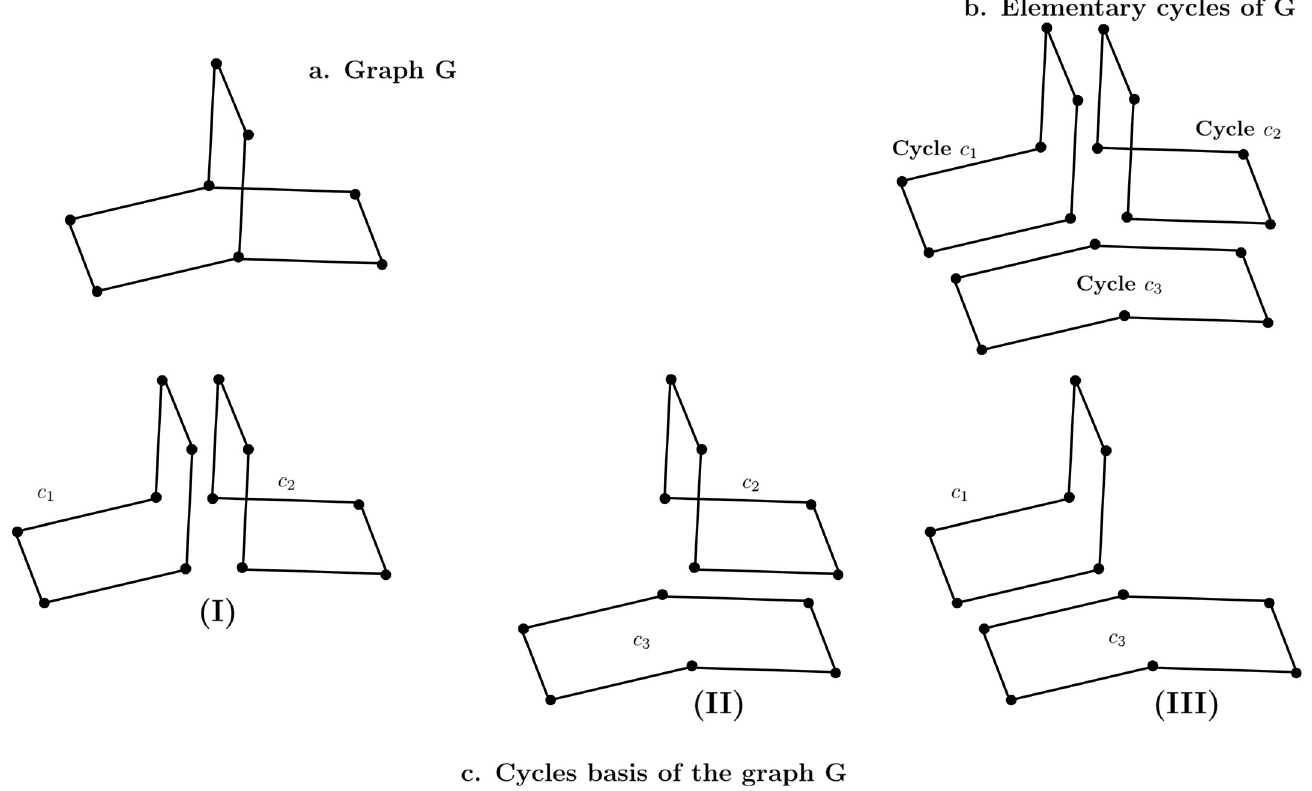
Fig 2. A graph G , elementary cycles of G and different minimum cycle basis of G . A graph can have different minimum cycle basis. From a minimum cycle basis, all elementary cycles of the graph can be generated.